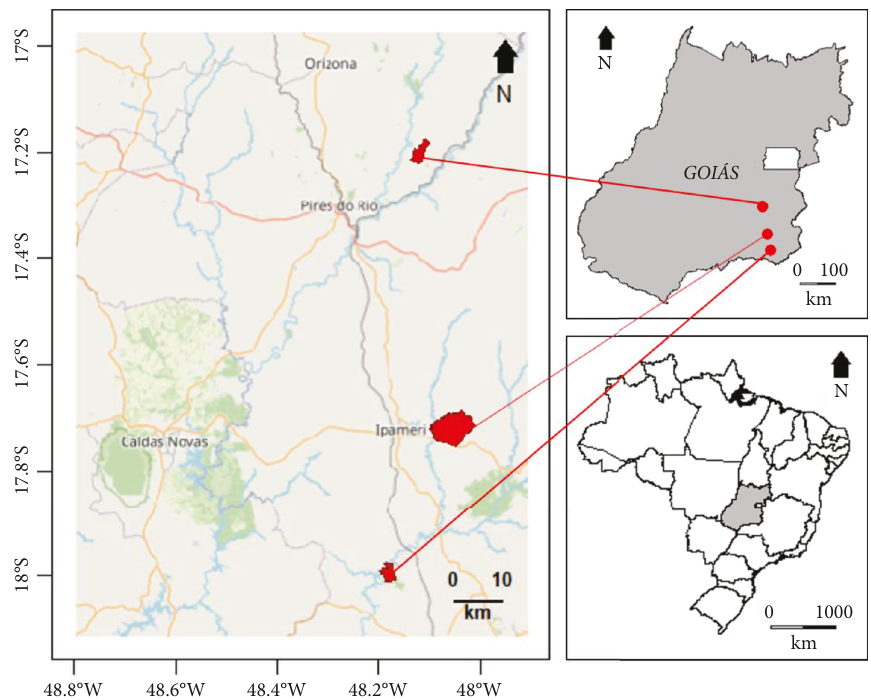
Figure 1: Location of the study areas in the southeast of Goi´as, Brazil. Basemap: OpenStreetMap ®